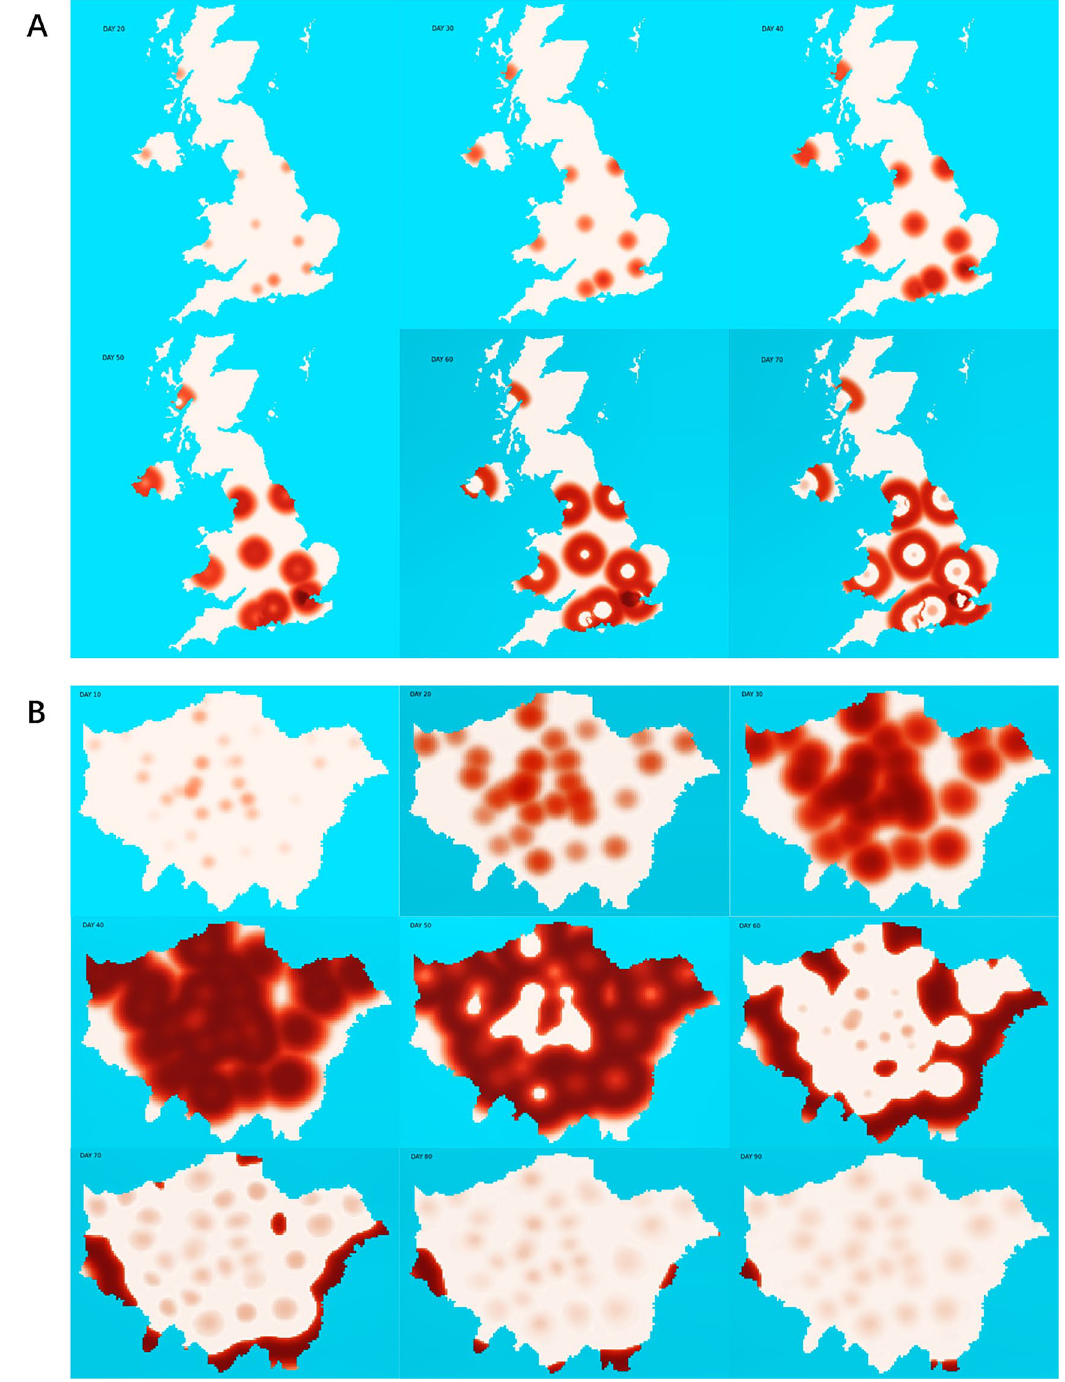
Figure 2. Visualized COVID-19 transmission without interventions in the UK and London. ( A ) Screenshots of visualized dynamic model of transmission in the UK from day 10 to day 60. The red saturation represents the severity of COVID-19. COVID-19 starts from a random spot in each region and spreads rapidly. In the outbreak centre, COVID-19 infection will reach a peak on day 50 and be cleared on day 60 when it is out of control in the whole country. ( B ) Screenshots of visualized dynamic model of transmission in London from day 10 to day 90. (Day-by-day transmission videos were generated by Pythons 3 https:// www. python. org using python package matplotlib https:// matpl otlib. org with initial maps from open-source software WordPress.org. Screenshots were generated by Windows10, more details were shown in the Results——Technical